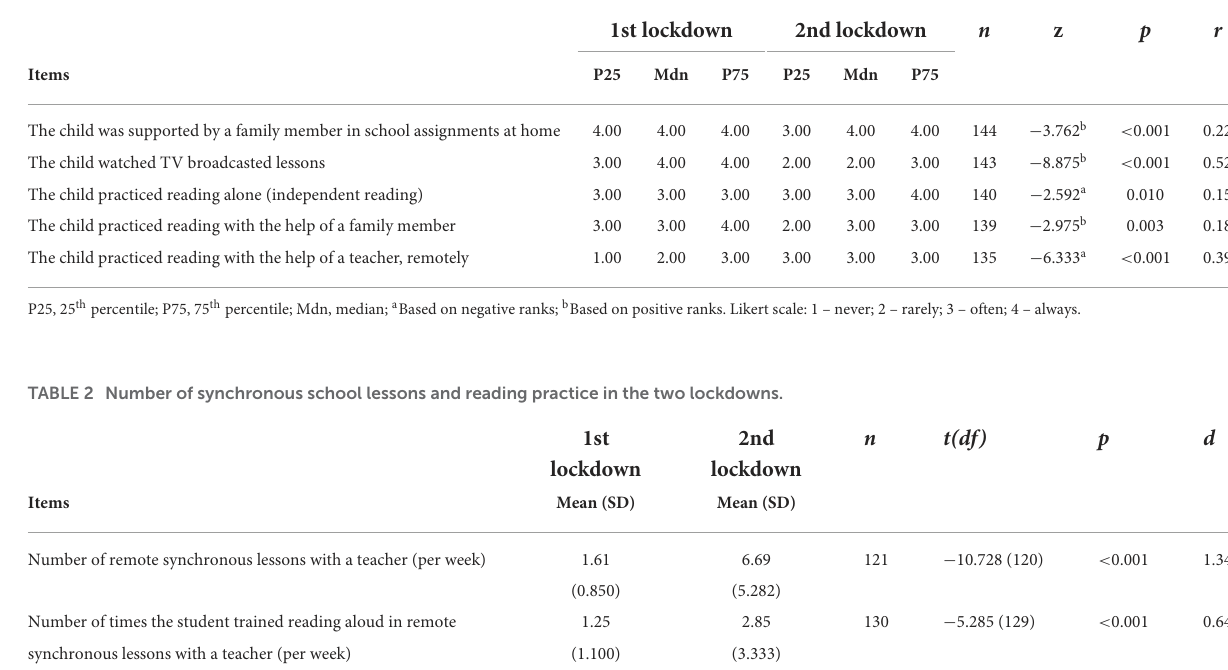
TABLE 1 Parents’ perceptions practices and learning support during the remote teaching in the first and second lockdowns.